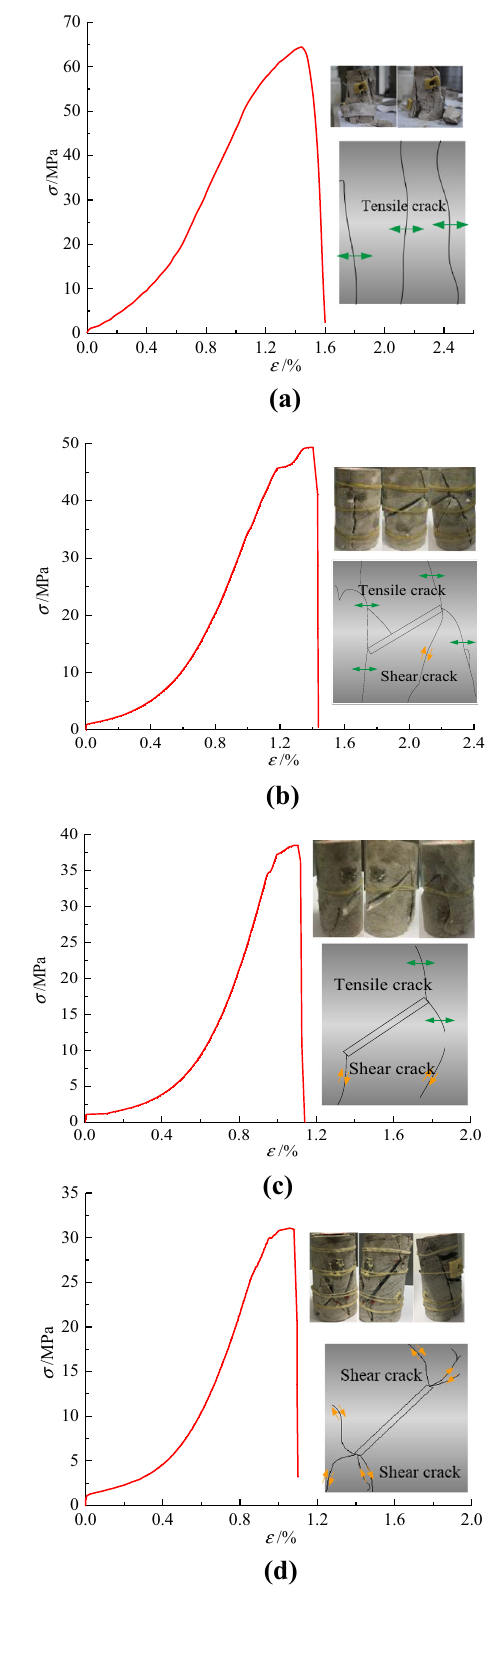
c Fig. 3 Stress-strain curve features and macroscopic fracture mor-